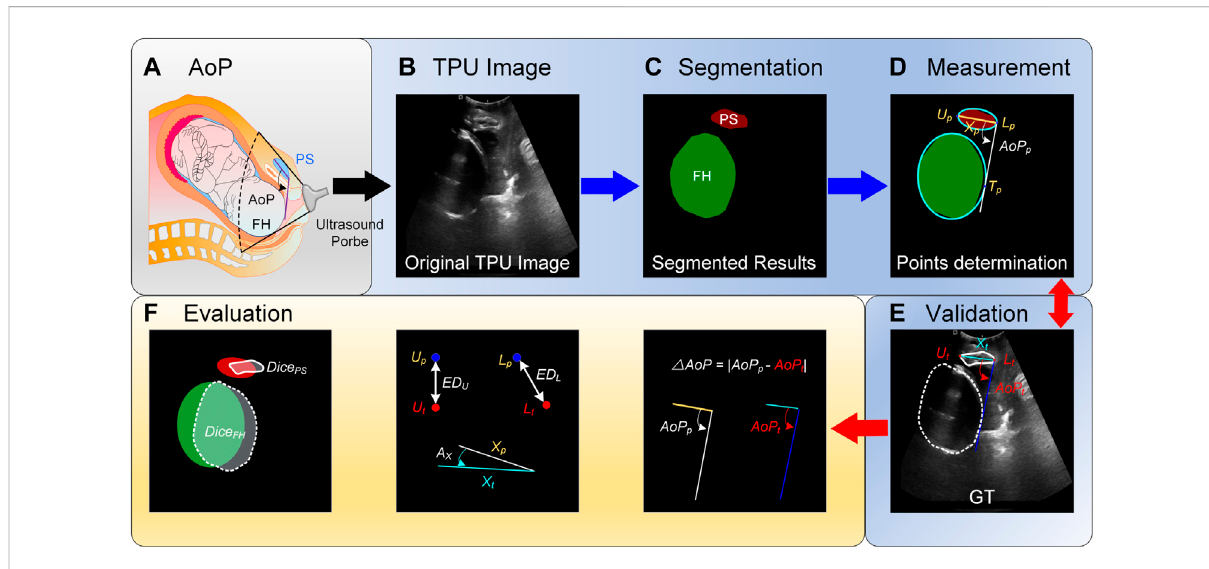
FIGURE. 1 Schematicdiagramoftheangleofprogression(AoP)thatismeasuredwithourproposedmethod. (A) AoPisde fi nedastheanglebetweenaline through the long axis of the pubic symphysis (PS) and a second line from the inferior end of the symphysis pubis tangentially to the contour of the fetalhead(FH). (B) Imagesare fi rstlyobtainedwiththetransperinealultrasound(TPU)probe. (C) AreasofPSandFHaresegmentedwiththeproposed method. (D) Segmentedareasare fi ttedwithellipticequationsandtherebythreekeypointsforcomputingAoParedetermined.Comparedwith ground truths (GTs) (E) , the proposed method is evaluated with several metrics (F)